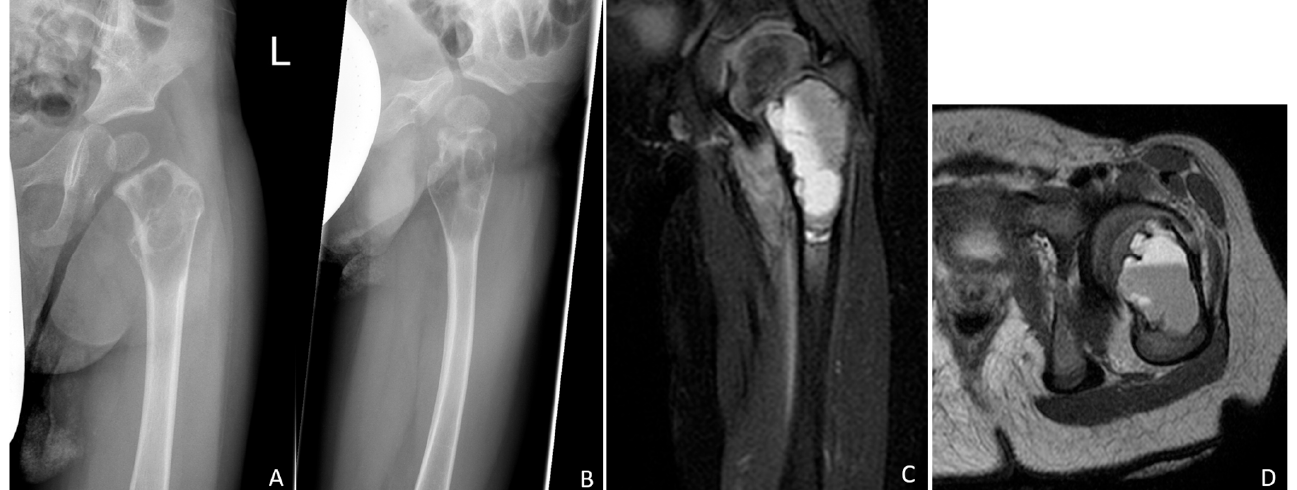
Figure 1. Conventional radiographs of the left hip joint showing the septated cystic lesion of the proximal femur extending immediately to the growth plate in two planes ( A , B ). Perforation of the thinned cortical bone is indicated in the lateral image ( B ). The magnetic resonance image clearly shows the multichambered fluid-filled cyst, which is confined to the proximal femur ( C , D ). In the axial section, the fluid levels are clearly visible ( D ).